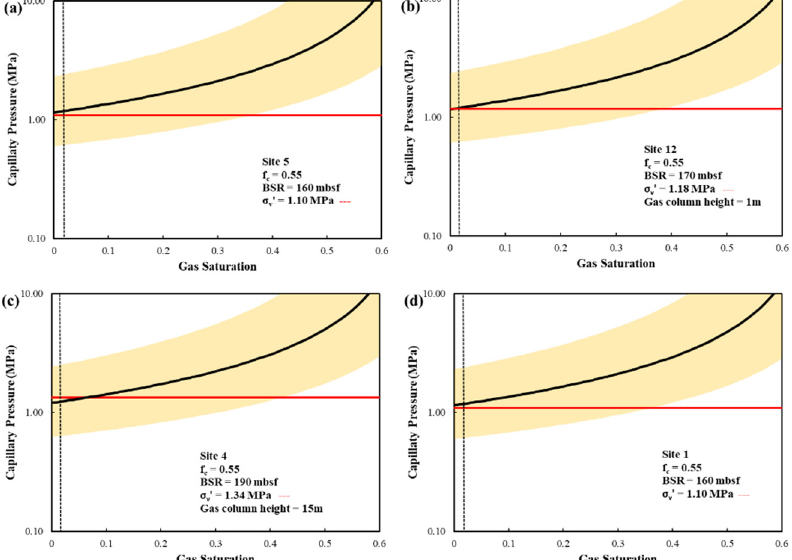
Figure 5. Capillary curves calculated using Equation (7) for the 4 sites. The sites are shown from west to east. Site 5 ( a ) is the westernmost, followed by Site 12 ( b ), Site 4 ( c ) and Site 1 ( d ). The black curve is the median capillary pressure, and the shaded region is the uncertainty ( ± 1 SD) from the capillary pressure parameters (Equations (8)–(10)). The red line is the fracture criterion calculated using Equation (5). The black dotted line represents the gas mobility threshold. The point where the red line intersects the black curve indicates the minimum gas saturation required to open fractures at BSR which is obtained by substituting Equation (7) into Equation (13) and solving for the saturations. Gas will open fractures at all saturation and pressure values greater than this value at the intersection point. Gas will migrate by porous flow (through rock matrix) instead of opening fractures at saturation values between this intersection point and gas mobility threshold.